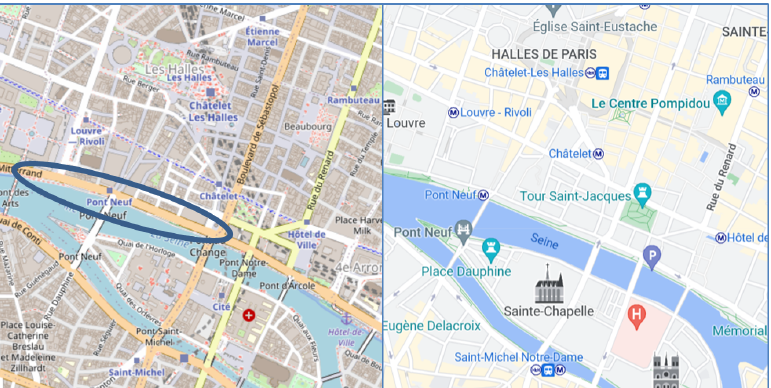
Figure 6. On the left is the OSM map that caused the trust disorientation experience, with the quay that is now pedestrian still represented as a secondary road. In the Google map, the quay is correctly represented as a pedestrian road (source: Google and OpenStreetMap